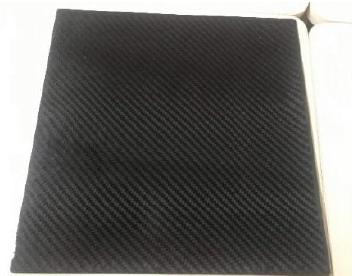
Figure 6. The carbon fiber broad after compression molding.